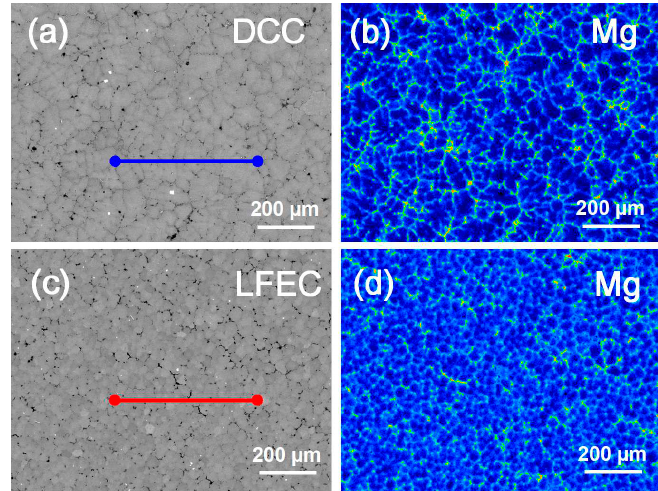
Figure 9. SEM images and Mg element mapping of 1/2 radius position of 5A90 as-cast alloy. ( a ) SEM image of DCC alloy, ( b ) Mg element mapping of DCC alloy, ( c ) SEM image of LFEC alloy, ( d ) Mg element mapping of LFEC alloy.